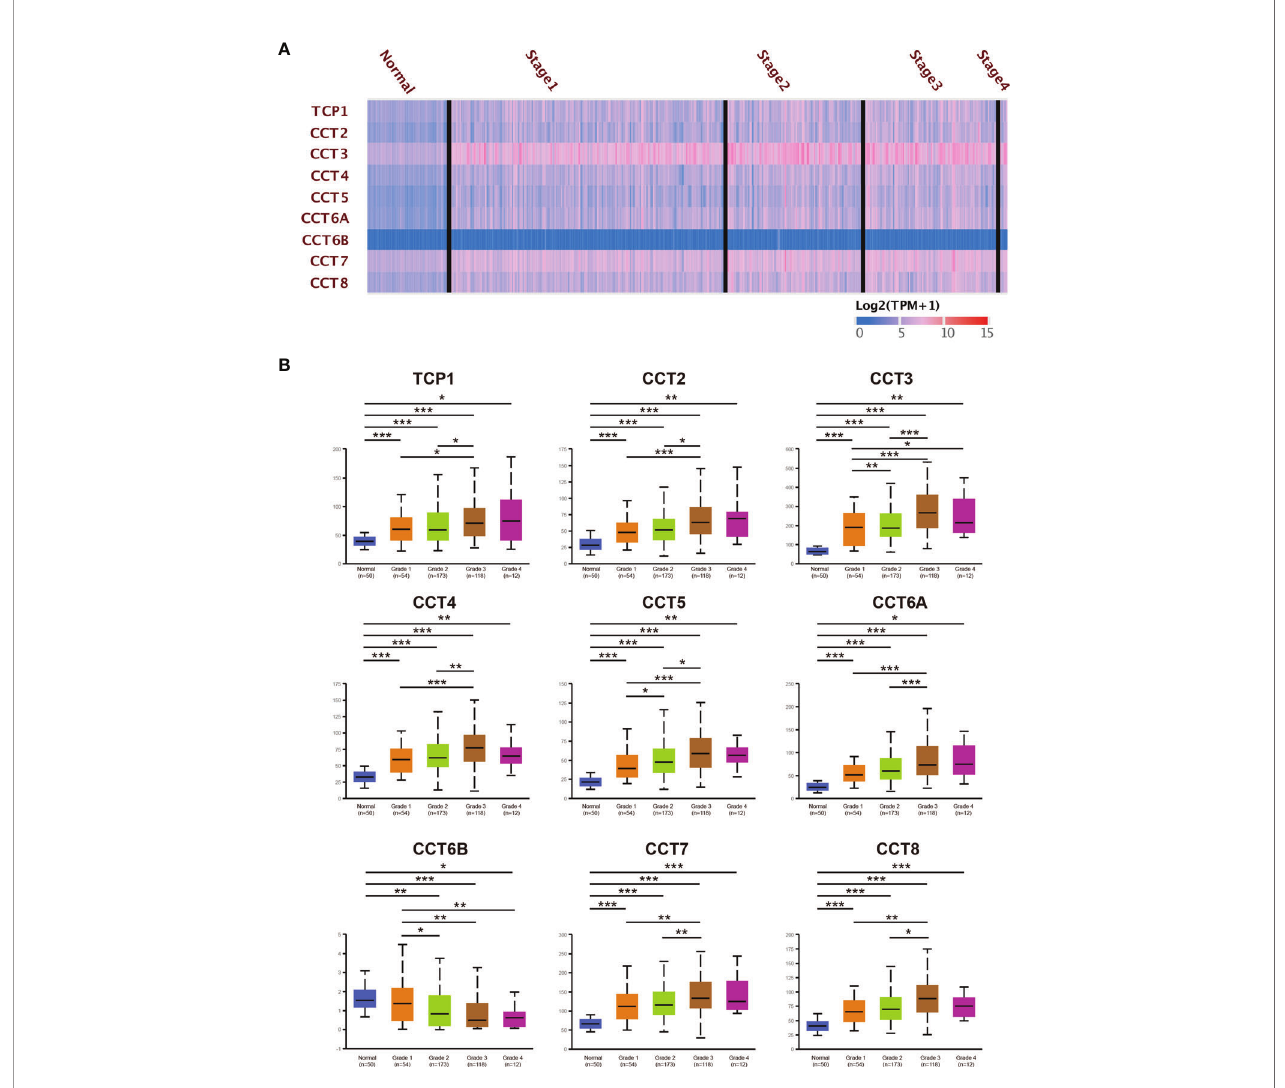
FIGURE 3 | Greater TRiC subunit mRNA expression levels are associated with higher HCC tumor grade (from UALCAN). (A) Heatmap shows the different expressed TRiC subunits in HCC patients with different grades. (B) The expression levels of TRiC subunits in HCC patients with different grades. *p < 0.05, **p < 0.01, ***p <